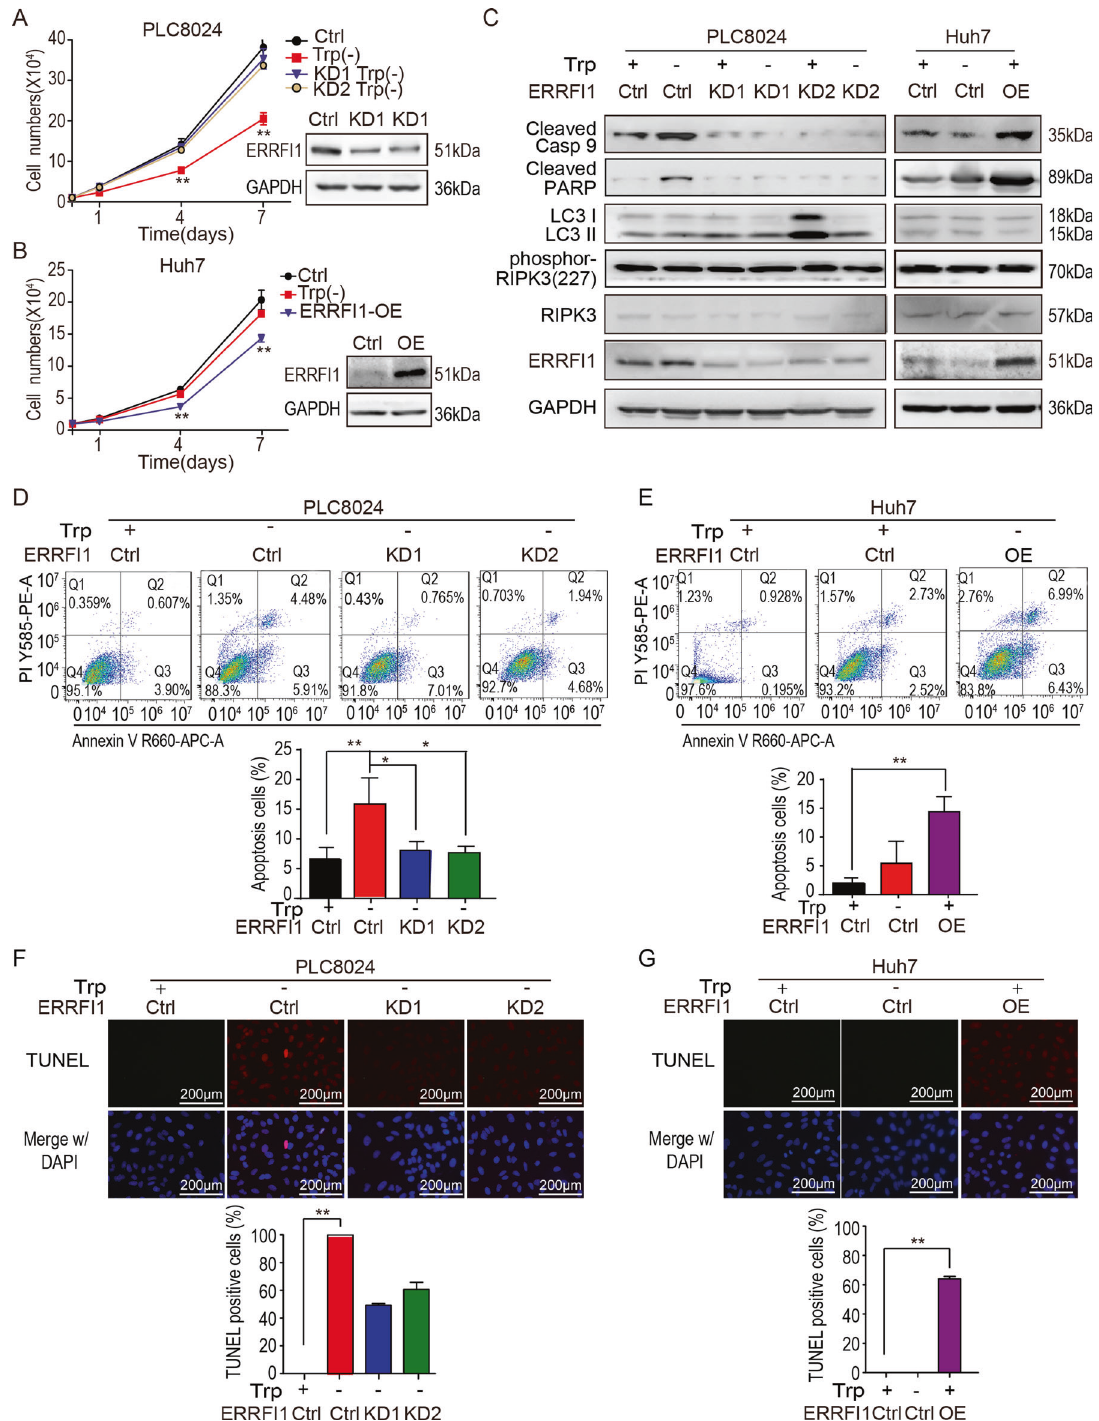
Fig. 3 ERRFI1 mediates tryptophan de fi ciency-suppressed HCC cells growth. A The effect of ERRFI1 knockdown on cell growth in sensitive PLC8024 cells by cytometry assay and western blot (** P < 0.01; * P < 0.05). B The effect of ERRFI1 overexpression on cell growth in resistant Huh7 cells by cytometry assay and western blot (** P < 0.01; * P < 0.05). C Detection of apoptosis markers in the sensitive PLC8024 cells depleted of ERRFI1 or in the resistant Huh7 cells overexpressing ERRFI1 with or without tryptophan supplementation by western blot. D , E The apoptosis assessment by fl ow cytometry assay in the ERRFI1 knockdown PLC8024 cells and the ERRFI1 overexpressed Huh7 cells with or without tryptophan supplementation. F , G The apoptosis assessment by TUNEL assay in the ERRFI1 knockdown PLC8024 cells and the ERRFI1 overexpressed Huh7 cells with or without tryptophan supplementation. Scale bar = 200